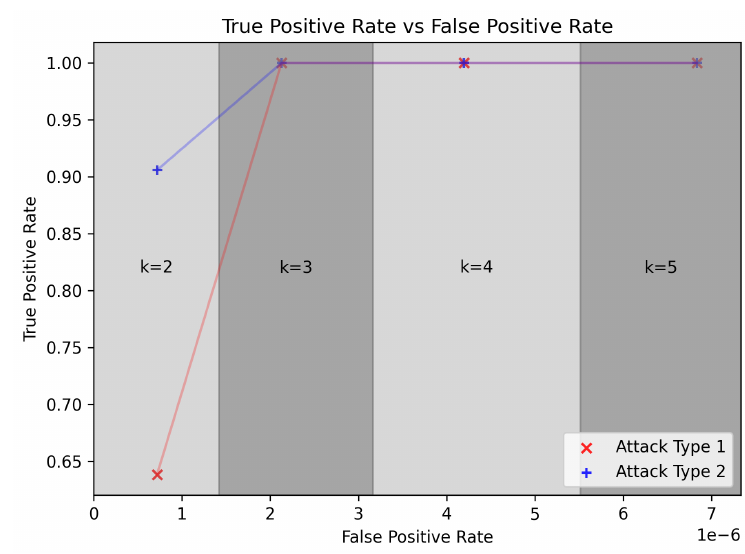
Figure 20. True positive and false positive rate of IDS for two attack types. Table 4. False positive rates for different values of hyper parameter k